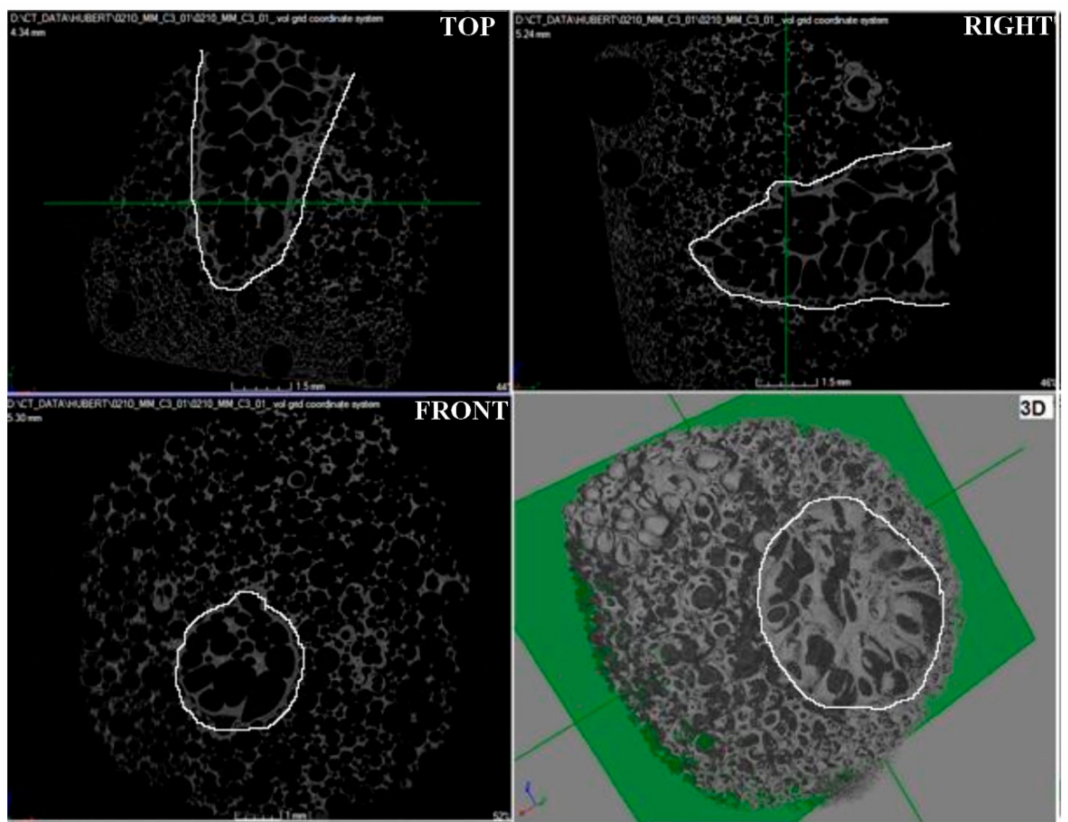
Figure 17. Microtomographic image of carbon sample M3.